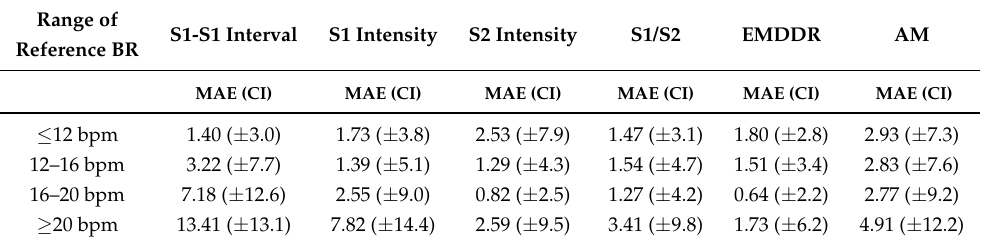
Table 8. MAE in bpm and CI between different BRs estimated from the standard and advanced methods.